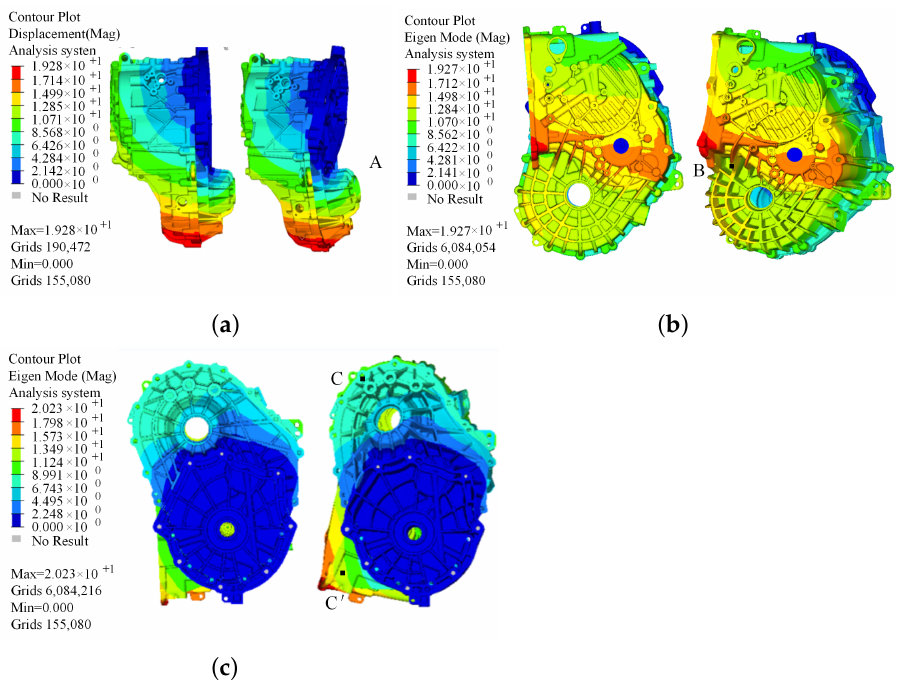
Figure 13. Comparison shape of the first three modes of the gearbox housing: ( a ) 1st mode shape (437.2 Hz); ( b ) 2nd mode shape (605.8 Hz); ( c ) 3rd mode shape (965.2